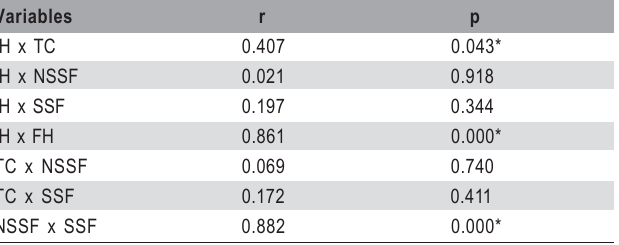
Table 3 - Pearson’s correlation test between the variables and halitosis in Group II.